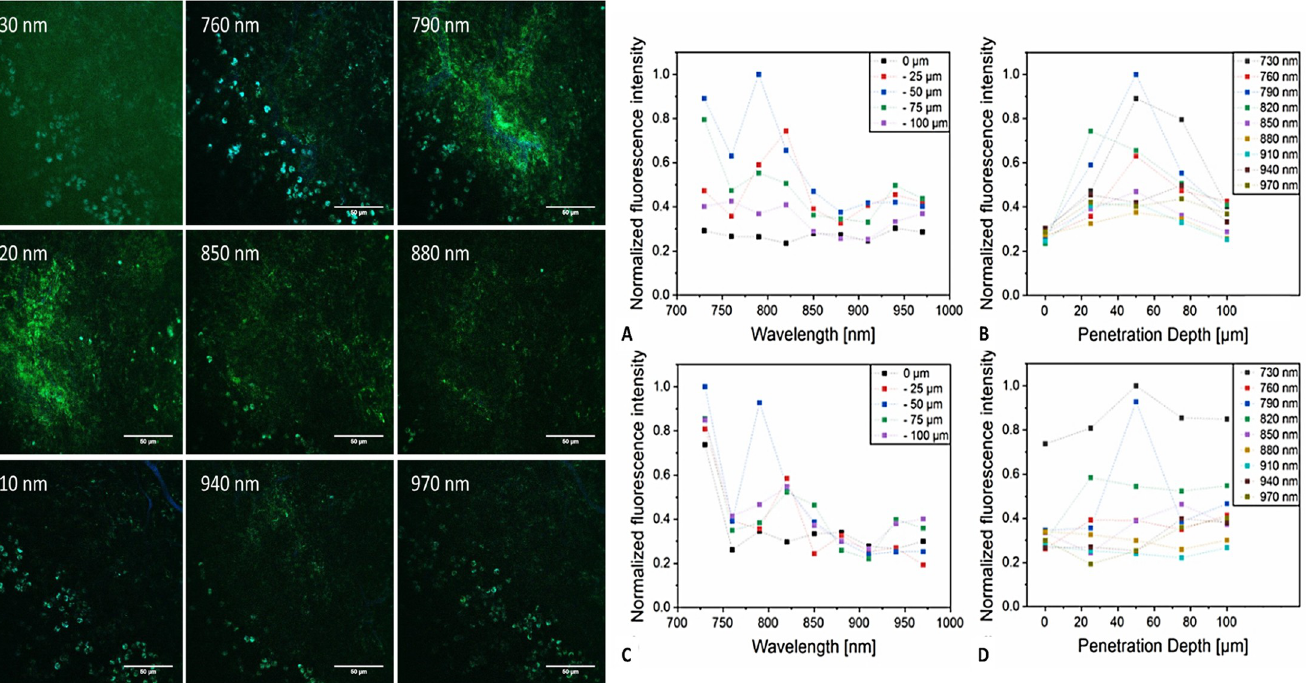
Fig 2. Comparison of different excitation wavelengths for imaging: [left] MPM images of the same region at the same depth in the liver at different imaging wavelengths (green = Rhodamine 6G, blue = FITC-Dextran; scale bar 50 μ m). [right] Diagrams considering penetration depths of different imaging wavelengths into hepatic tissue stained with FITC-Dextran (blue, graphs A and B ) and Rhodamine 6G (green, graphs C and D ).